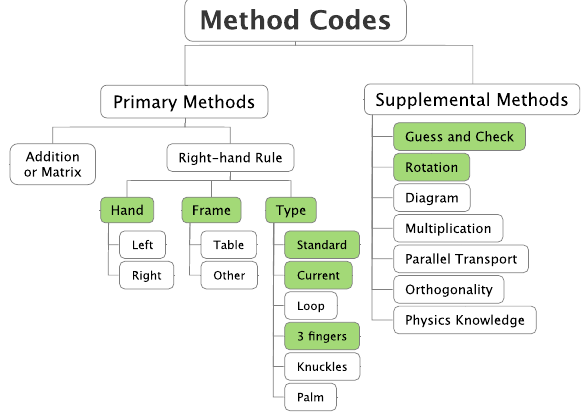
FIG. 8. Graphical depiction of method codes and subcodes. Those in green are discussed in the text and in Table V.